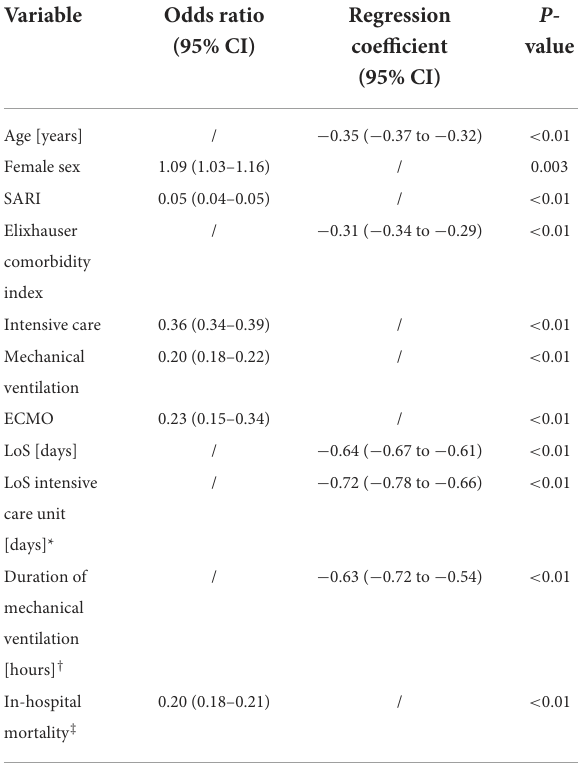
TABLE 3 Linear trends over